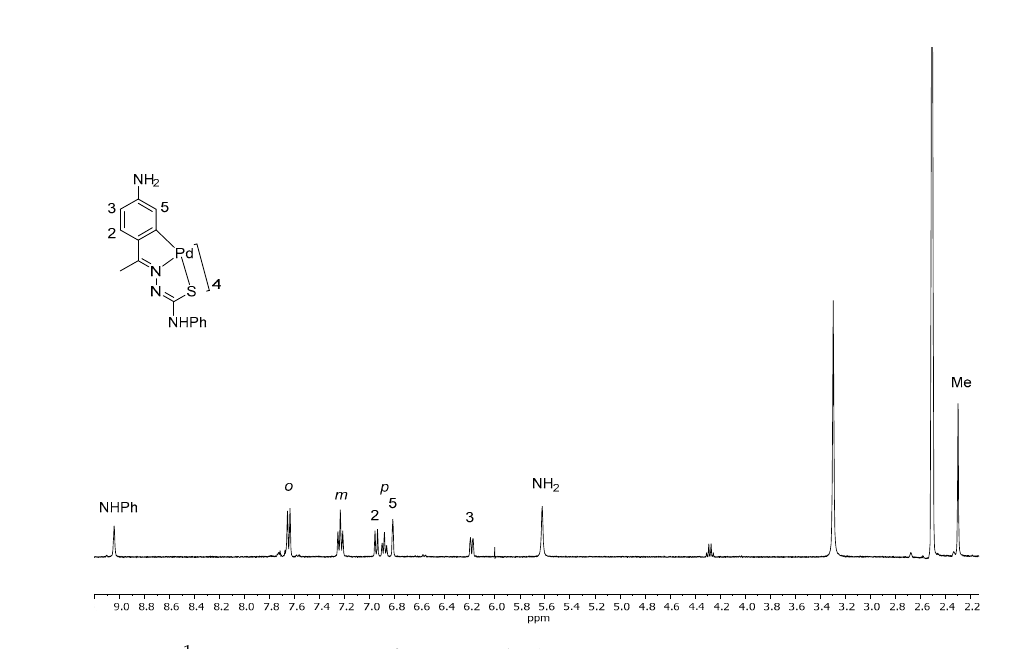
Figure 2. 1 H-NMR spectrum of compound 1d in DMSO. Table 2. Assignation of the NMR signals of compounds 1a – d .